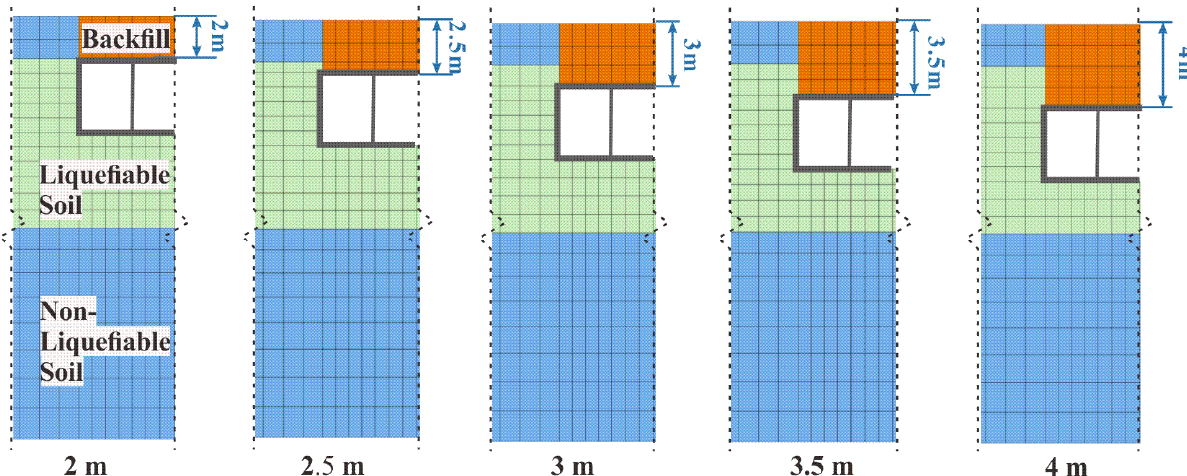
Figure 2. Stratigraphic conditions and location of the utility tunnels in the numerical models.